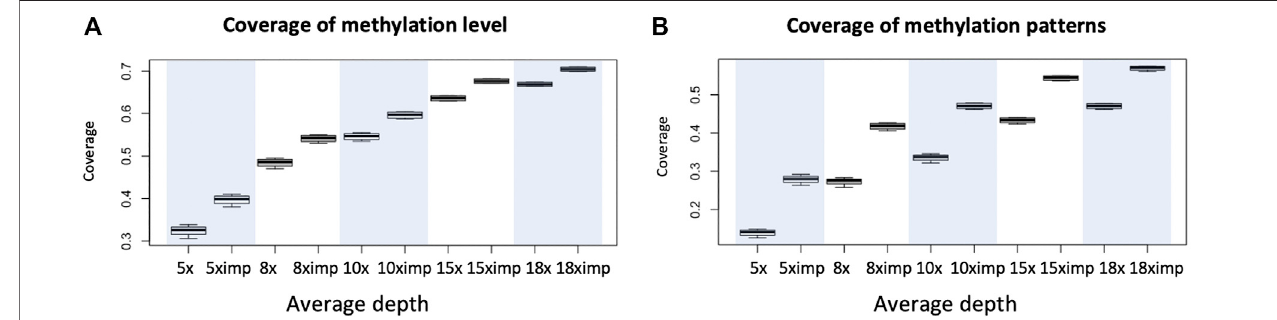
FIGURE 2 | An illustration of increases in coverage for the evaluation of methylation level and methylation heterogeneity for WGBS data with common depths. (A) Coverage (percentage of genomic regions in terms of windows) of possible evaluation of methylation level before and after imputation evaluated with requirement of minimum depth of 8 reads at each cytosine. (B) Coverage (percentage of genomic regions in terms of windows) of possible evaluation of methylation heterogeneity before and after imputation using window sizeof3 CpG and minimum8 reads per window. Eight waschosenfor itisthe minimum number ofreads required for us to see all possible patterns, if they all appear. Each boxplot is based on 1 chromosome and 4 libraries (WGBS) (4 data points). Since methylation patterns are pro fi led using sliding windows of one cytosine and a window is 3 CpG so coverage is calculated as the number of windows available for downstream analyses divided by total number of CpGs within the chromosome.